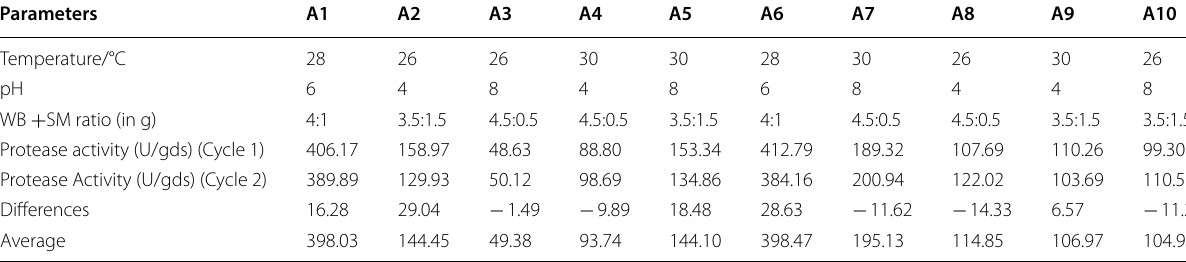
Table 4 Experimental conditions and results of experimental setup I for protease production Parameters